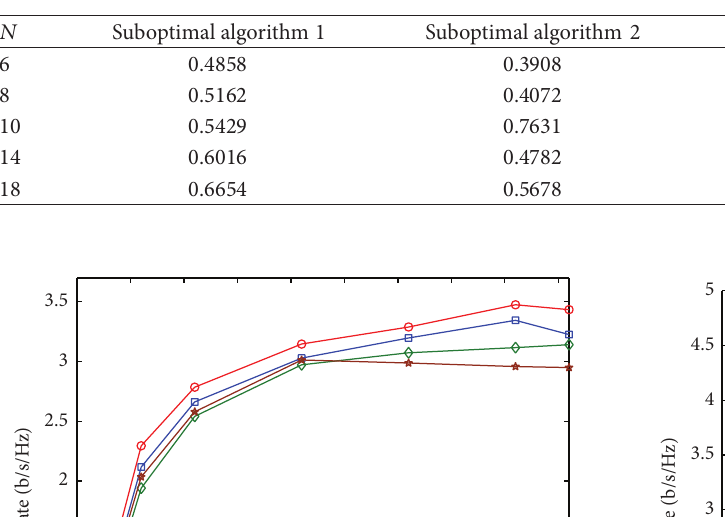
Table 2: Average running time (in seconds) comparison for the four algorithms when the number of subchannels 𝑁 changes, 𝐷 = 150 m, = 𝑃 = 3 W, and 𝑇 = 𝑇 = 0.15 W. 𝛼 = 0.5 , 𝑃 𝑆 𝑅 1 2